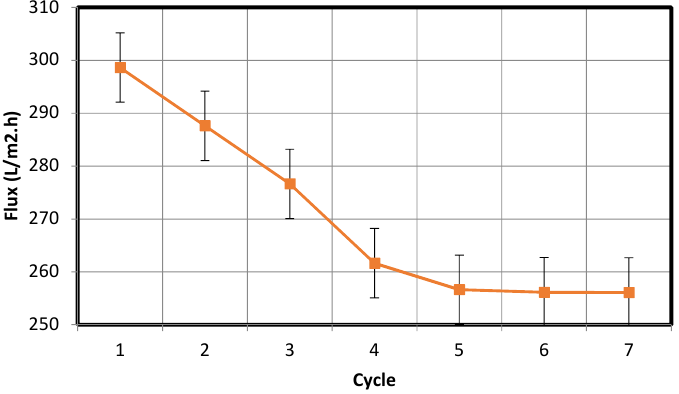
Figure 15. Periodic filtration for oil separation.